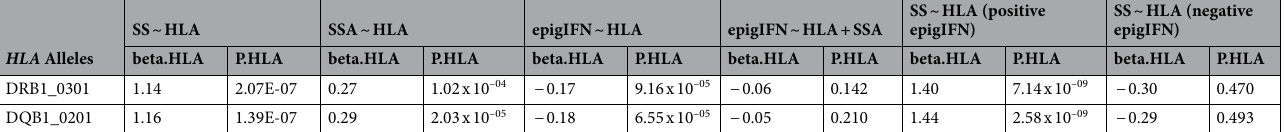
Table 1. Genetic associations between HLA variation, presence of Anti-La/SSA autoantibodies and epigenetic IFN signature. β reflects the additive effect of allele dosage for different HLA alleles and P is the associated significance level. The association between HLA genetic variation, SS and SSA was determined by means of logistic regression adjusted by sex and age. The association between HLA genetic variation and epigIFN was determined by linear regression models adjusted by sex, age, cell proportions and batch effects. epigIFN refers to the epigenetic IFN signature. DNA methylation at IFI44L gene (cg13452062) was used as a proxy for epigIFN. Patients exhibiting DNAm > 0.8 were classified as negative epigIFN. Patients exhibiting DNAm < 0.8 were classified as positive